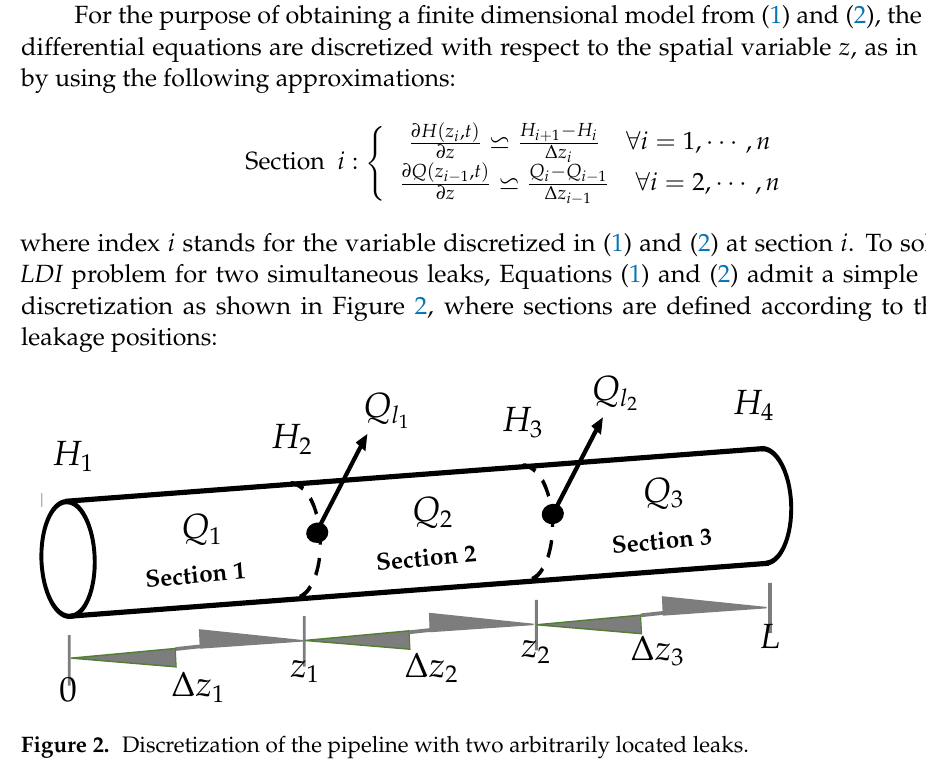
Here Q l represent the leaking flows that can be modeled as: 1,2